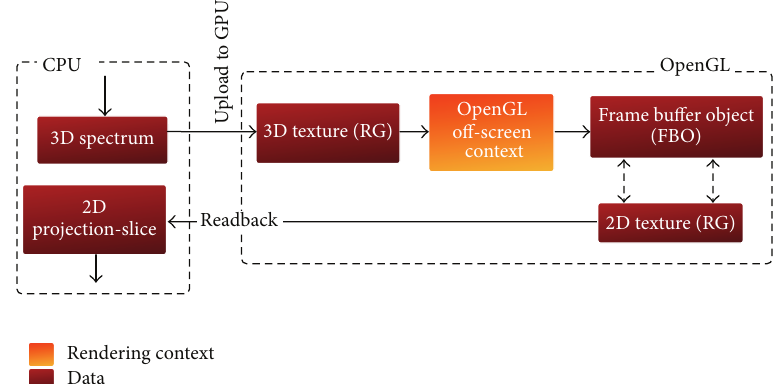
Figure 3: Communication between the computational context and OpenGL off-screen rendering context.